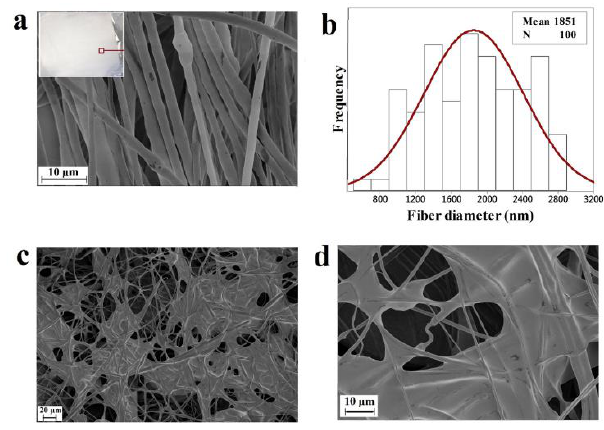
Figure 1. Scanning electron micrographs of polyhydroxybutyrate (PHB) fibers ( a ) along with the fabricated fiber mat (upper inset), PHB fiber diameter distribution ( b ), and sour orange juice (SOJ)-coated PHB fibers membrane at different magnifications of 20 µm and 10 µm ( c , d ).